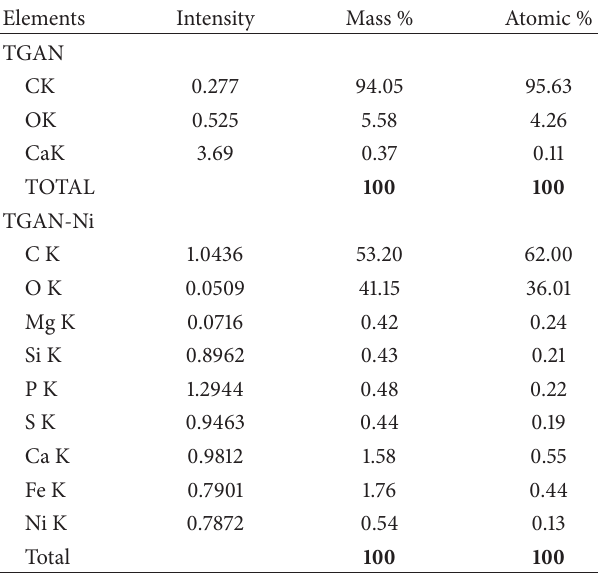
Table 2: Data for the elements presented in